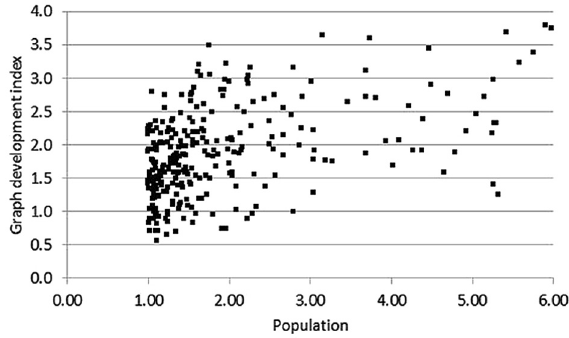
Fig. 16. Population and graph development index value for small towns and big villages in the south- west region of Poland. Source: own